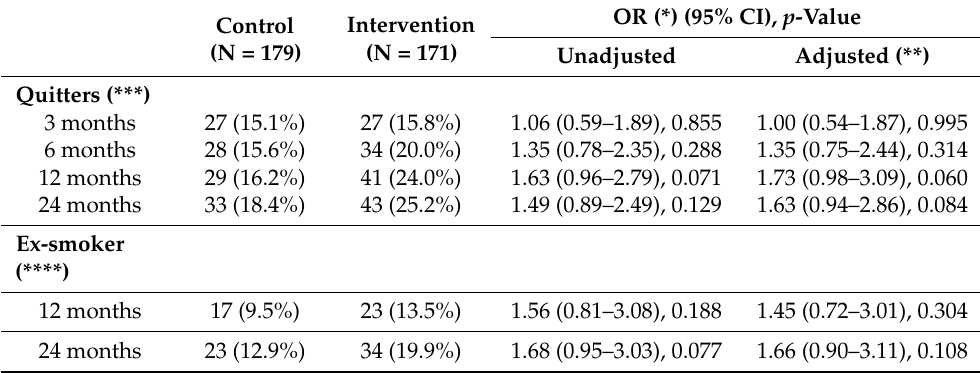
Table 3. Cross-sectional logistic regression analysis of the effect of the intervention on smoking cessation at each